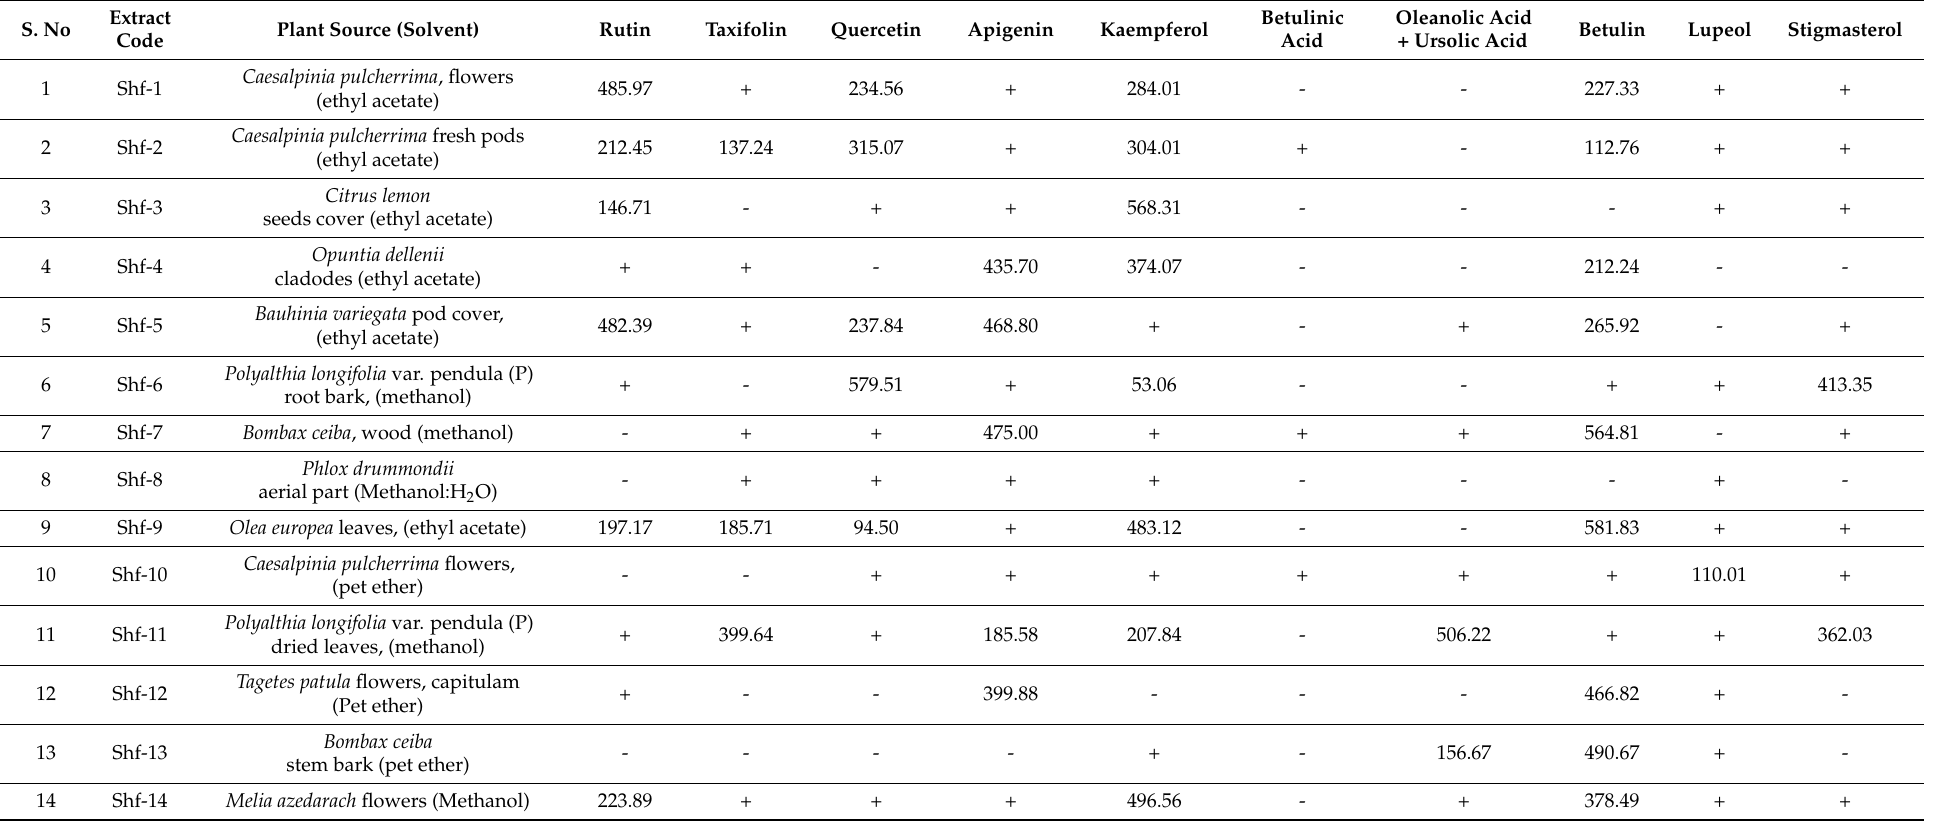
Table 6. Analysis of plant